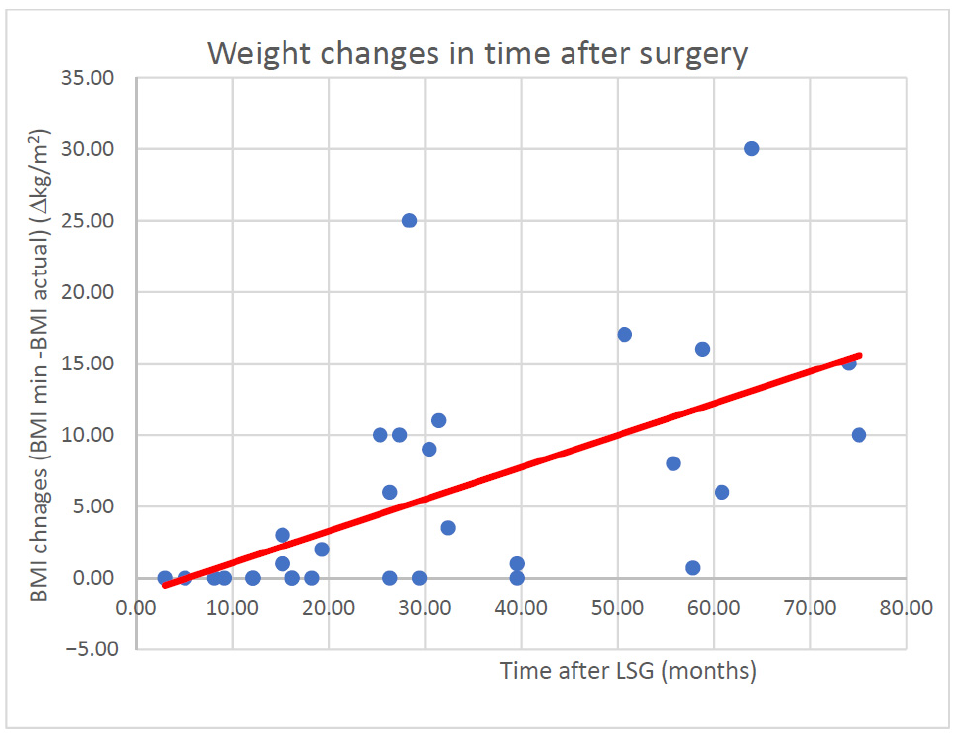
Figure 1. Relationship between change of BMI (yo-yo effect) and time (in months) elapsed since LSG.